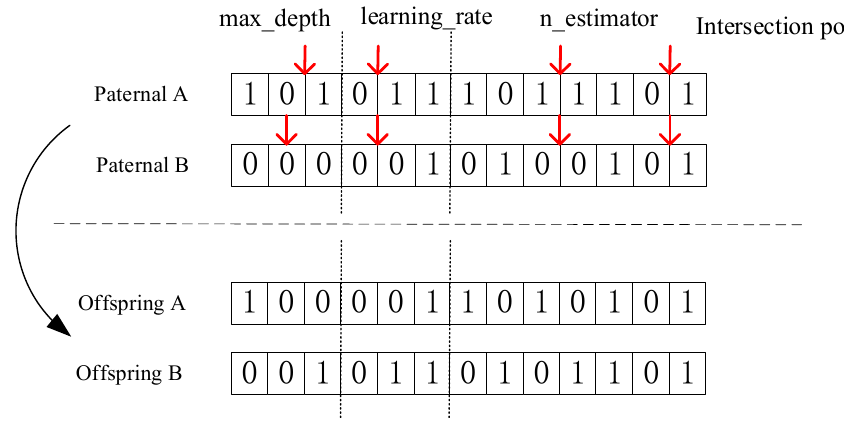
Figure 6. Crossover Operator.